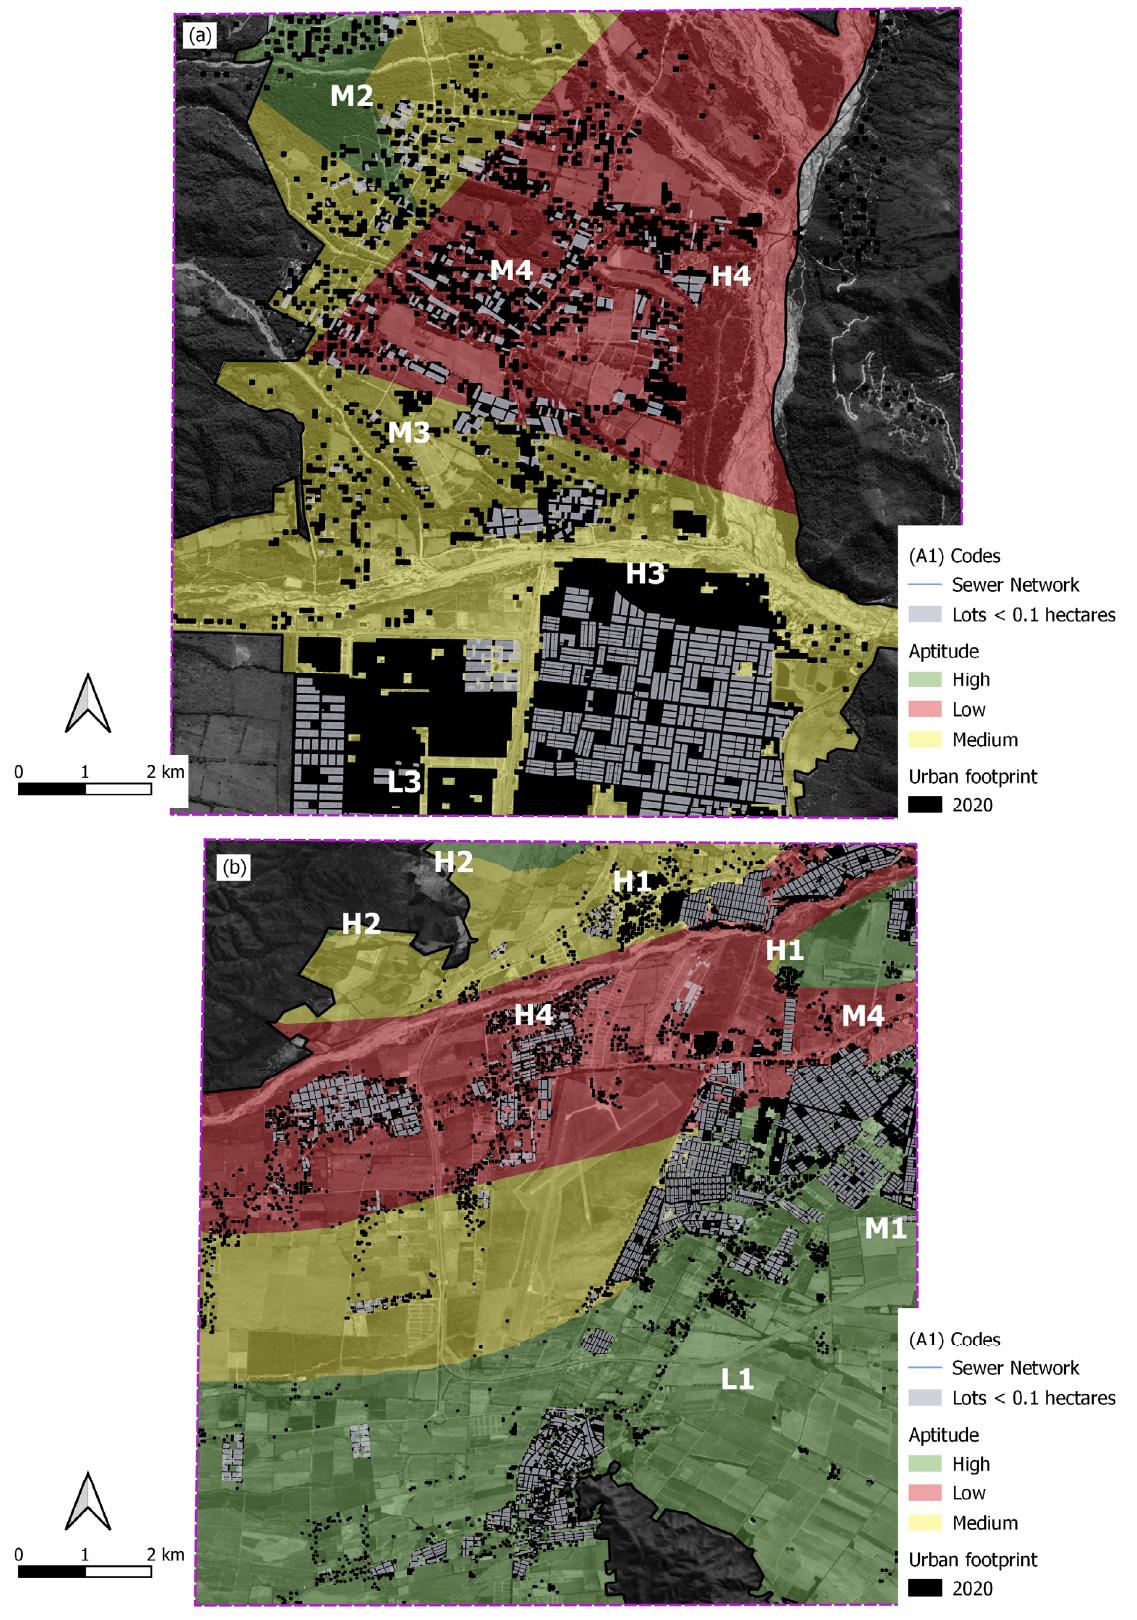
Figure 6. Detailed pictures of the selected AOI ( a ) and ( b ) in the Planning Map. Urban footprint and lots sizes less than 0.10 hectares are showed. For more details regarding presented codes please see Table